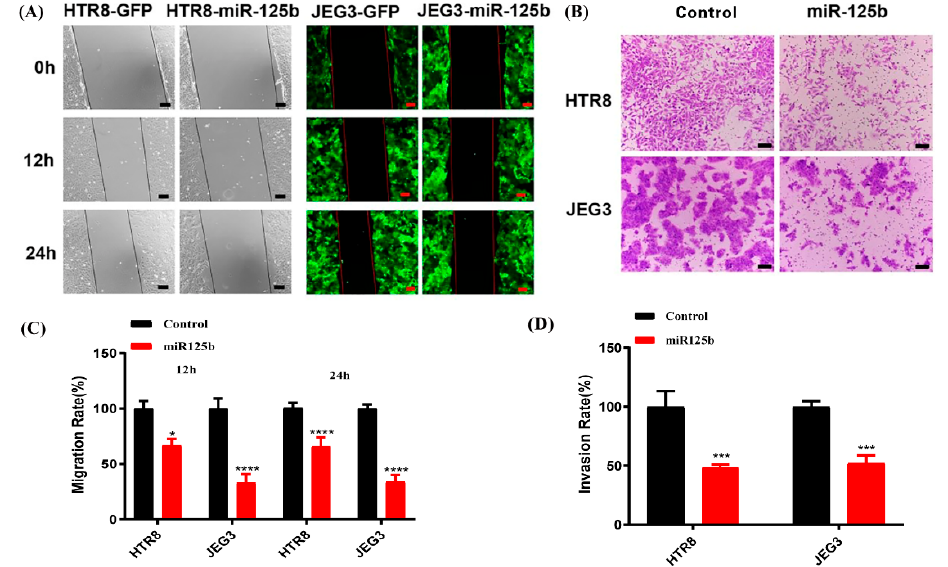
Figure 6. The effect on the migration and invasion ability of HTR8 and JEG3 cell lines after miR- 125b treatment. ( A ): The effect on the migration ability of HTR8 and JEG3 cell lines after miR125b treatment; ( B ): the effect on invasion ability of HTR8 and JEG3 after miR-125b treatment; ( C , D ): data are presented as mean ± SEM, n = 3. * p < 0.05, *** p < 0.01, **** p < 0.001.